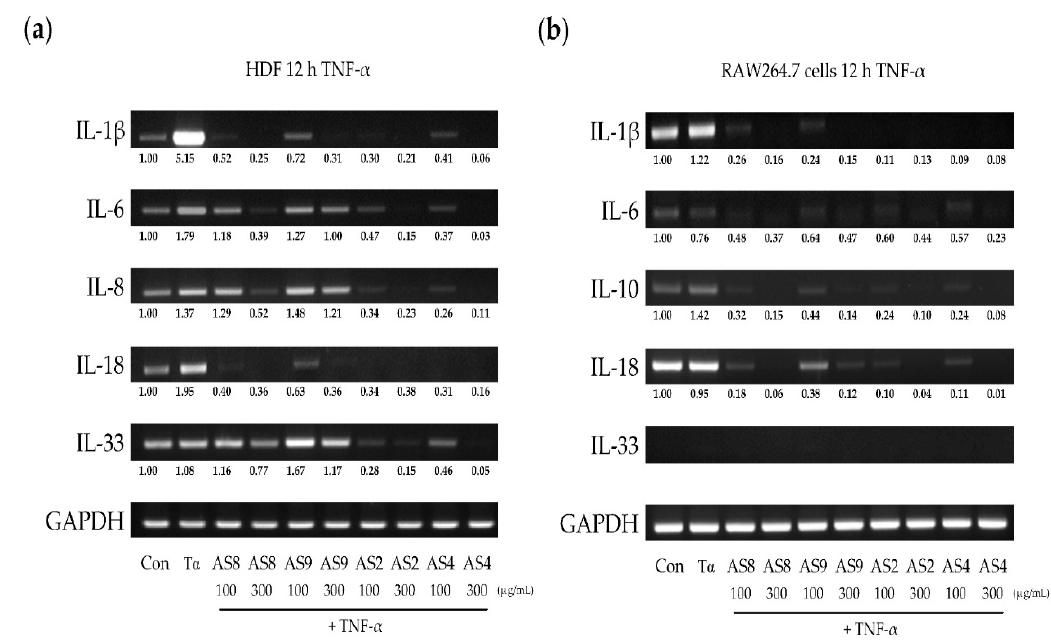
Figure 5. Changes in cytokine expression induced by tumor necrosis factor (TNF- α ) after treatment of ( a ) HDFs and ( b ) RAW 264.7 cells with AS extracts.